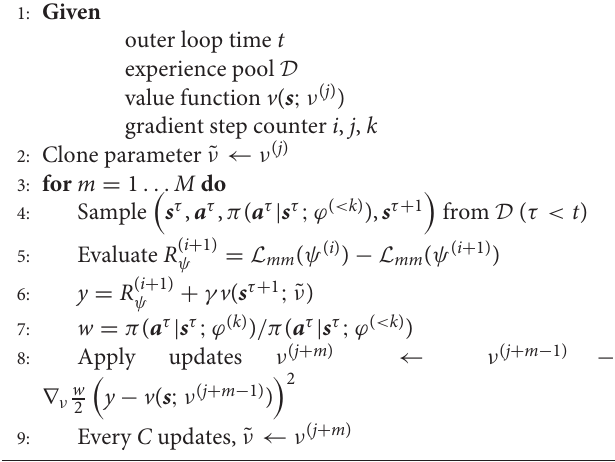
Algorithm 2 Fitted Policy Evaluation [cf. Heess et al.